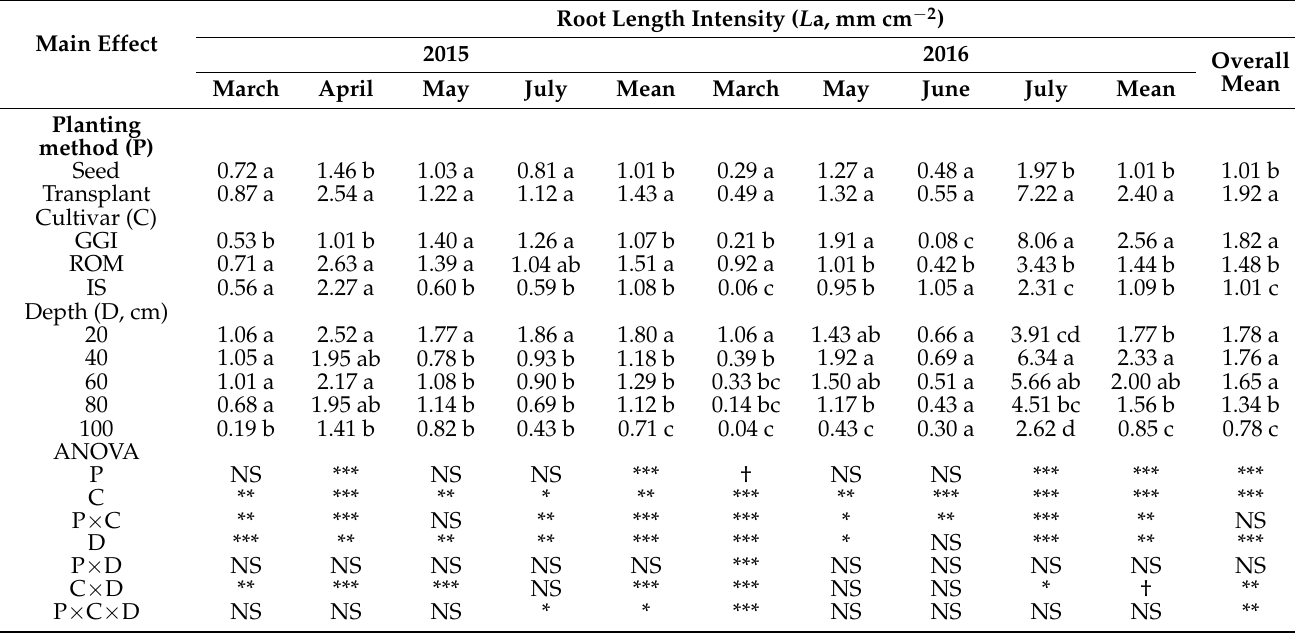
Table 1. Mean root length intensity ( L a, mm cm − 2 ) of artichoke cultivars (Green Globe Improved (GGI), Romolo (ROM), and Imperial Star (IS)) as influenced by planting method (direct seeding—Seed, and transplanting—transplant) and soil depth during 2015 and 2016 seasons. Data were collected using the minirhizotron root